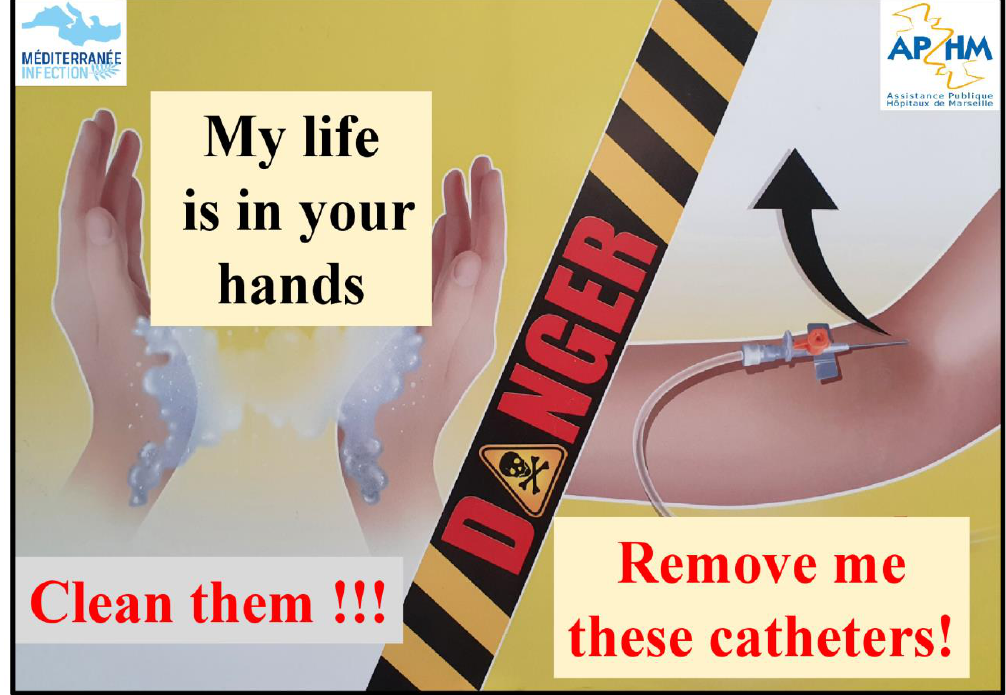
Figure 3. Display on bedroom doors, on the “ health care”